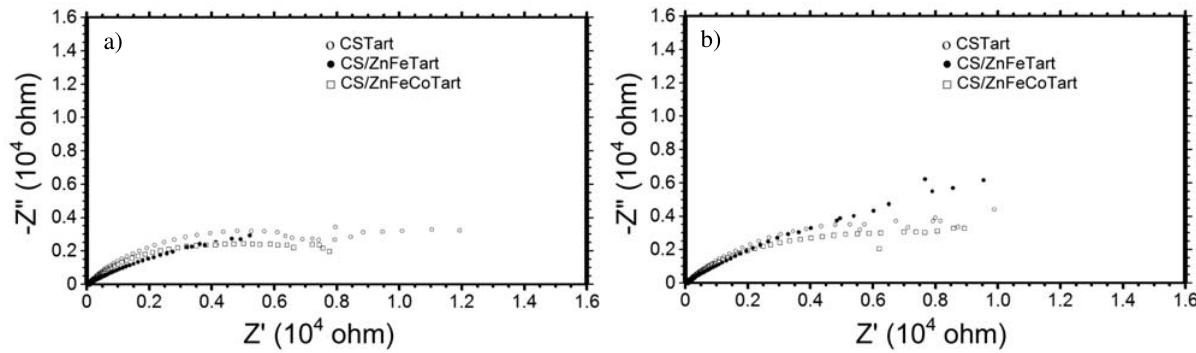
Fig. 8. The Nyquist curves of electrodes, after (a) 48 h and (b) 168 h of exposure time in 3.5% NaCl solution.